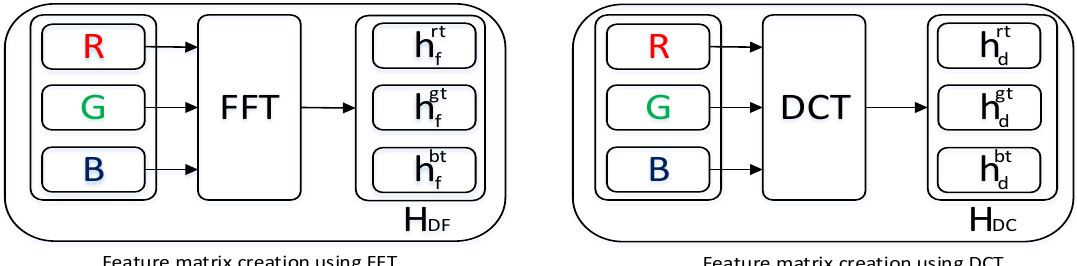
Figure 5. Feature-Selection Procedure from images when we use DFT and